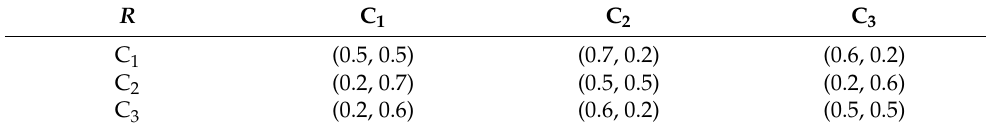
Table 9. The intuitionistic-preference relationship for the three indices (C 1 –C 3